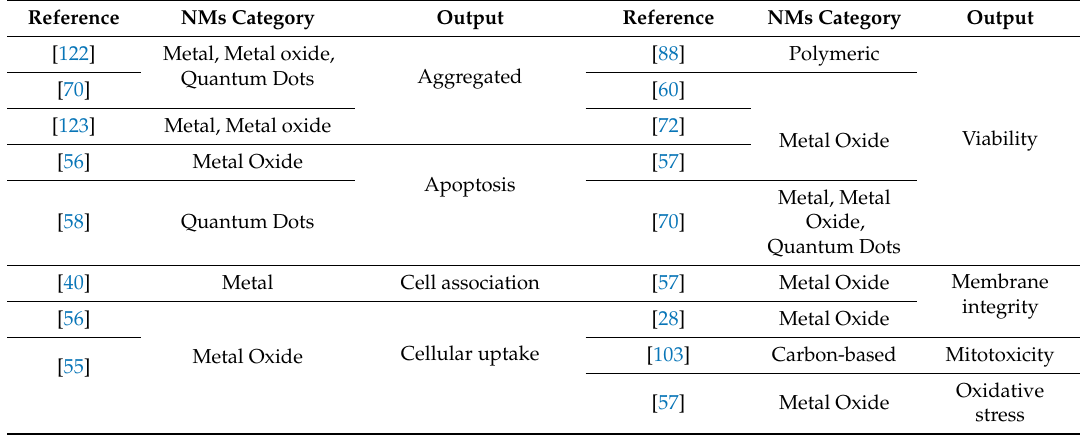
Table 6. Endpoints predicted by a neural network extracted from the studies